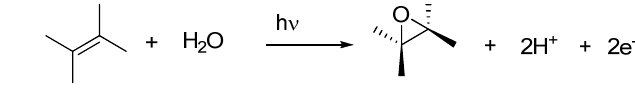
Figure 13. Hydrocarbon oxygenation as electron donor in photocatalysis [144].